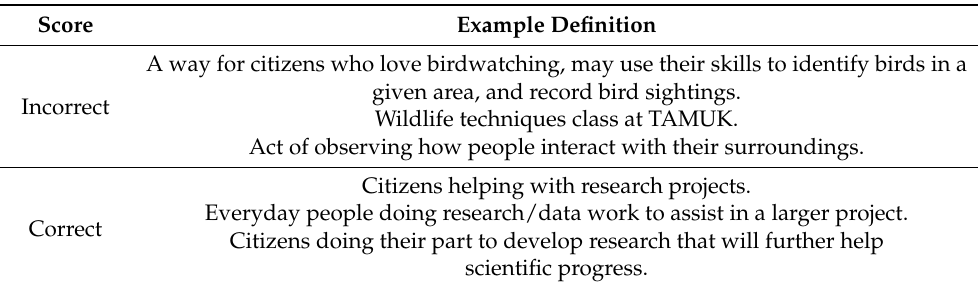
Table 2. Example student definitions of citizen science provided on pre- and post-surveys at Texas A&M University-Kingsville, Kingsville, TX, USA in Fall